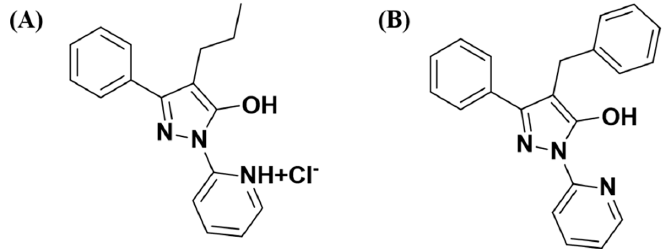
Figure 1. The chemical structures of ( A ) Ewha-18278 (NOX inhibitor) and ( B ) Ewha-18212 (Internal standard (IS)).